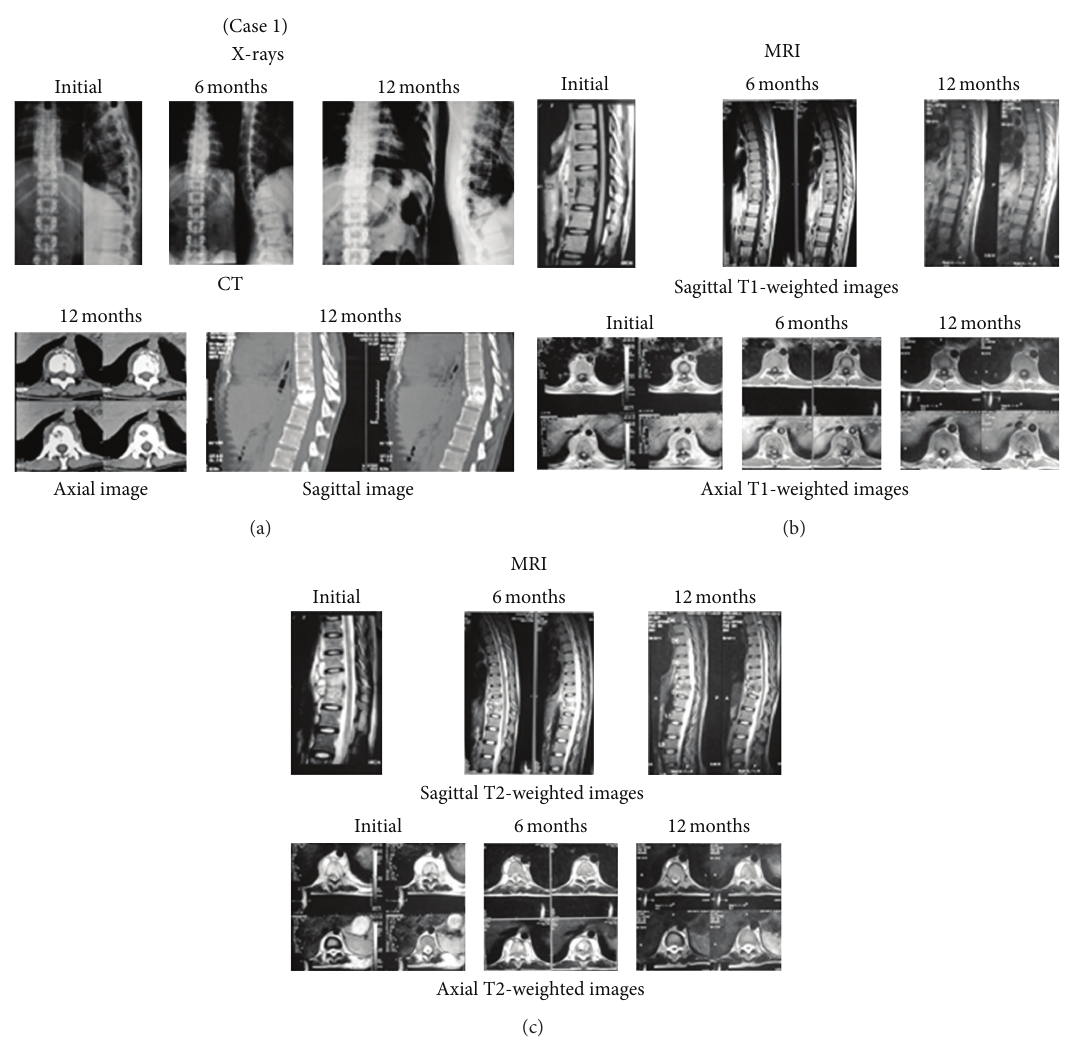
Figure 2: Tubercular spondylitis thoracic spine (D10-D11). Patient had a good subjective outcome and all changes in laboratory and radiological (MRI, CT, and X-rays) parameters showed improvement by the end of 12 months. Fusion was achieved at 12 months. No complications were seen and sinus which was present at initial presentation completely healed at her 18th month followup. (a) shows initial, 6-month, and 12-month X-rays and CT scan of the patient. (b) shows initial, 6-month, and 12-month sagittal and axial T1-weighted images. Disease completely healed at 12 months. (c) shows initial, 6-month, and 12-month sagittal and axial T2-weighted images. Disease completely healed at 12